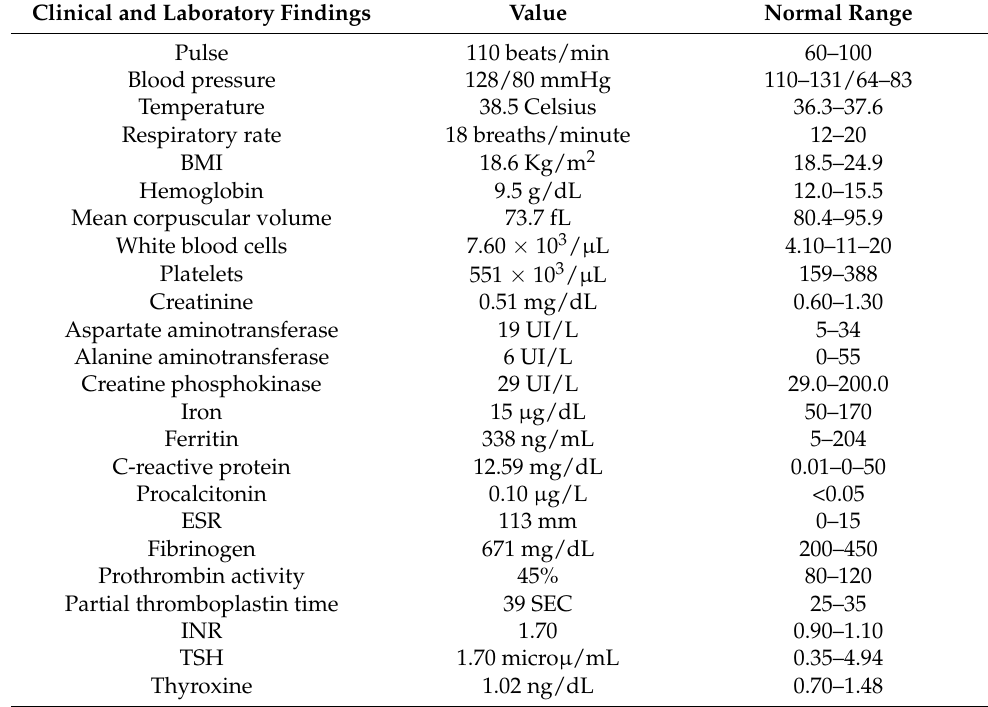
Table 1. Clinical and laboratory findings obtained at admission. Clinical and Laboratory